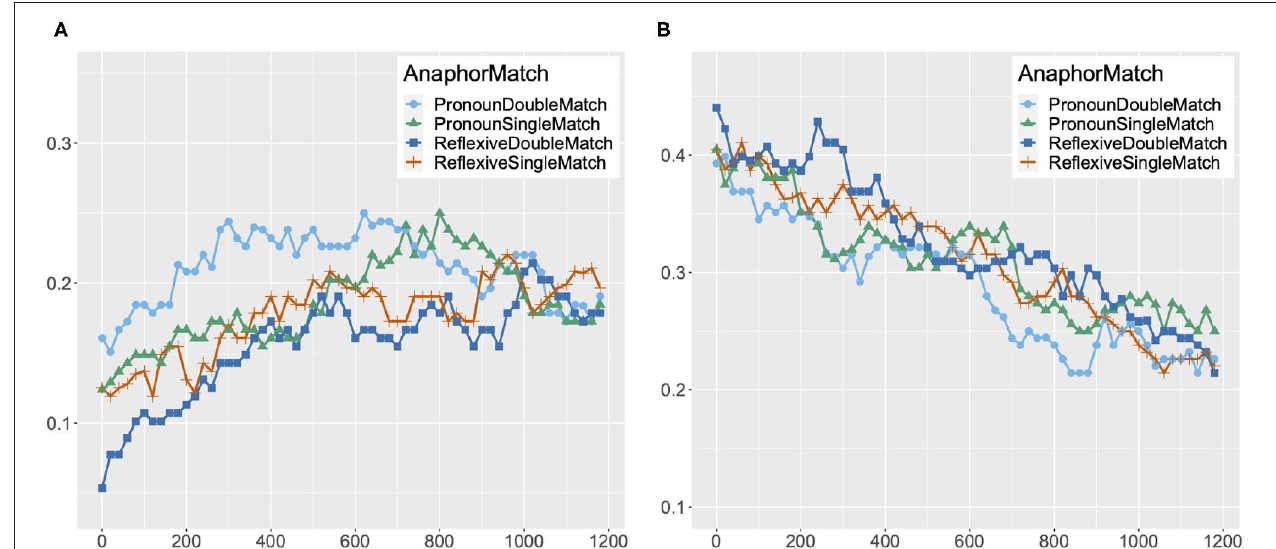
FIGURE 6 | Proportion of looks to distractor and target object image in double/single match condition at every 20 ms from the onset of the target anaphor to 1,200 ms after the onset, Experiment 2. (A) Proportion of Looks to Distractor Object. (B) Proportion of Looks to Target